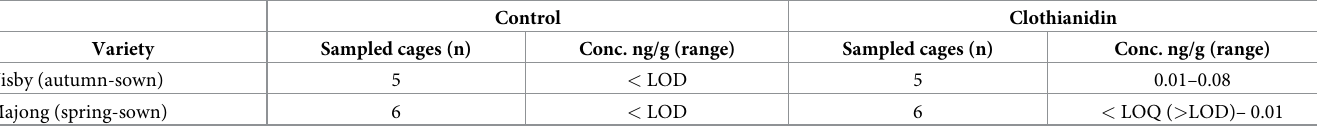
Table 2. Clothianidin residues in rapeseed leaves of autumn-sown and spring-sown